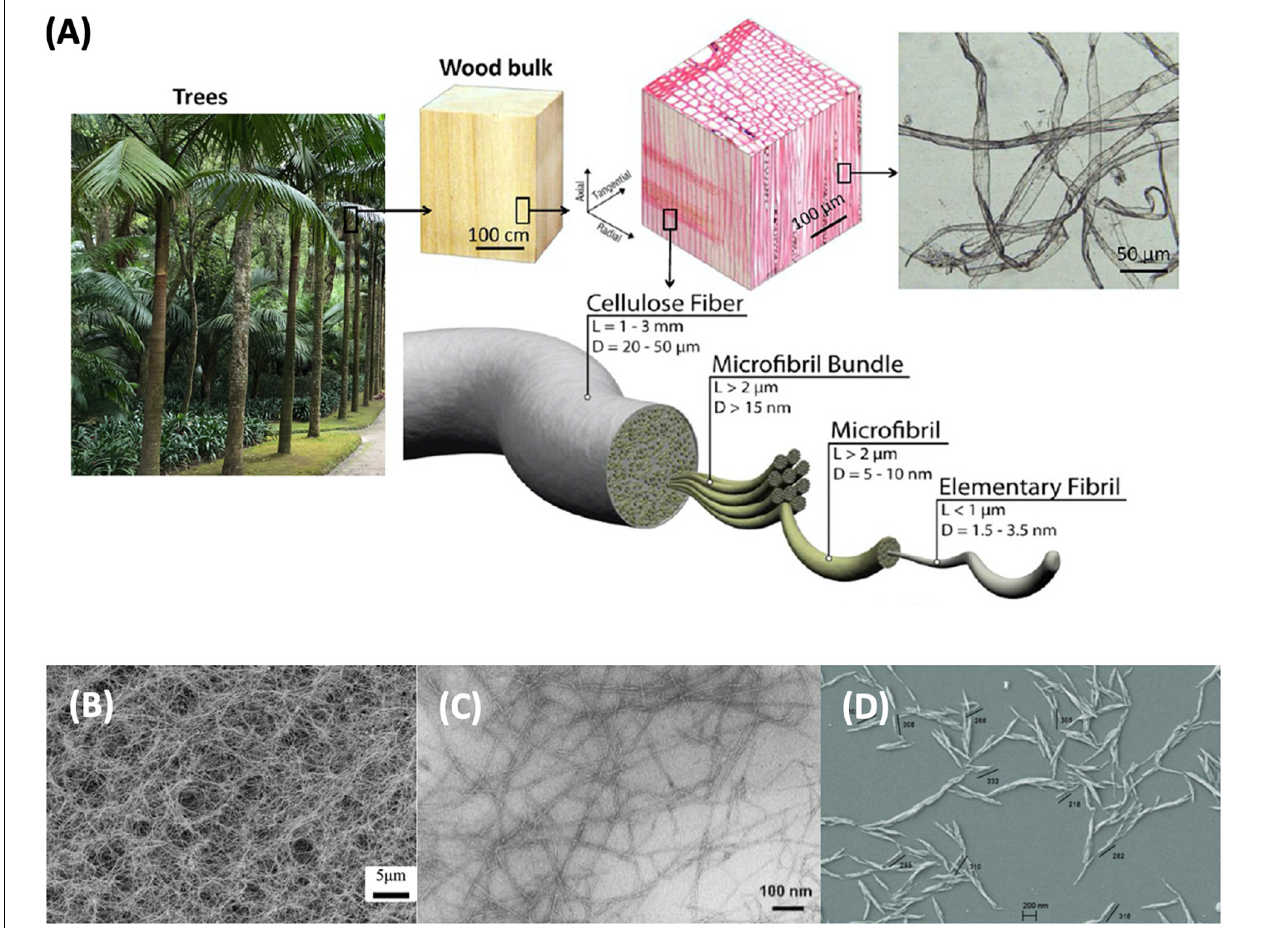
FIGURE 3 | (A) Hierarchical structure of wood fibers: Reprinted (adapted) with permission from Zhu et al. (2013). Copyright (2013) American Chemical Society. Comparison microscopic image of; (B) bacterial nanocellulose (Li et al., 2017): Published by The Royal Society of Chemistry, (C) nanofibrillated cellulose: Reprinted (adapted) with permission from Saito et al. (2007). Copyright (2007) American Chemical Society and, (D) nanocrystalline cellulose (Anžlovar et al.,